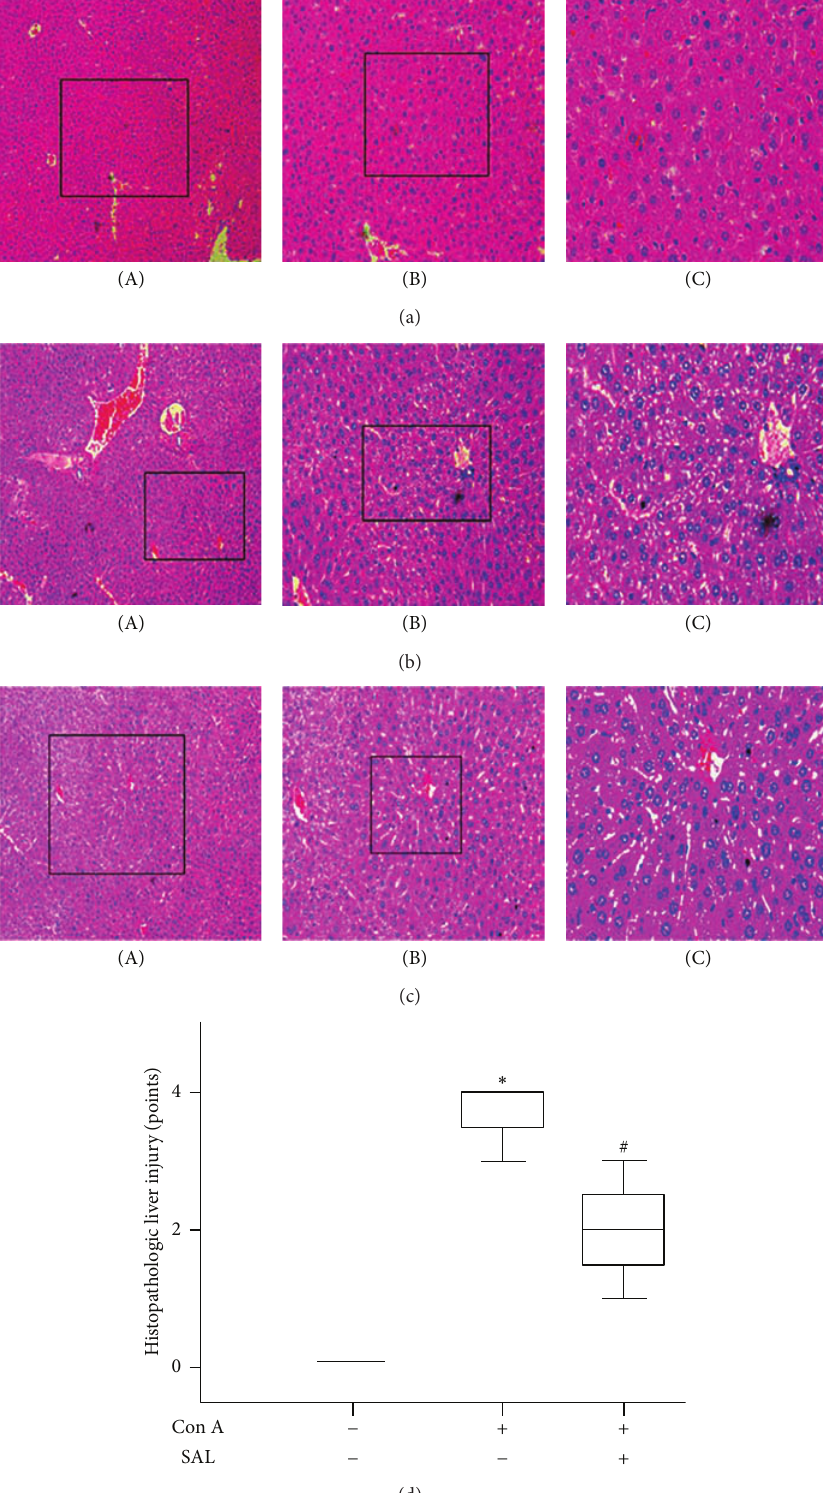
Figure 2: Histopathological changes of mice. The liver tissue sections were stained with H&E. Black squares in (A) were magnified into (B), and blank square in (B) was magnified into (C). Original magnification was × 100 for (A), × 200 for (B), and × 400 for (C). (a) Representative microscopic appearance of liver tissue in control group. (b) Representative microscopic appearance at 12h after Con A administration. (c) The effect of salidroside on the degrees of liver injury. (d) Severity of all sections was scored blind by three pathologists. ∗ 𝑃 < 0.01 versus control group, # 𝑃 < 0.05 versus Con A group. ( 𝑛 = 10 mice per